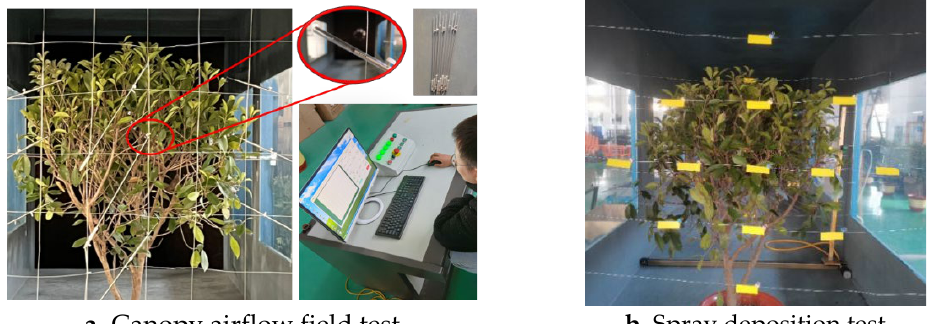
Figure 4. The canopy airflow field and spray tests in the wind tunnel.